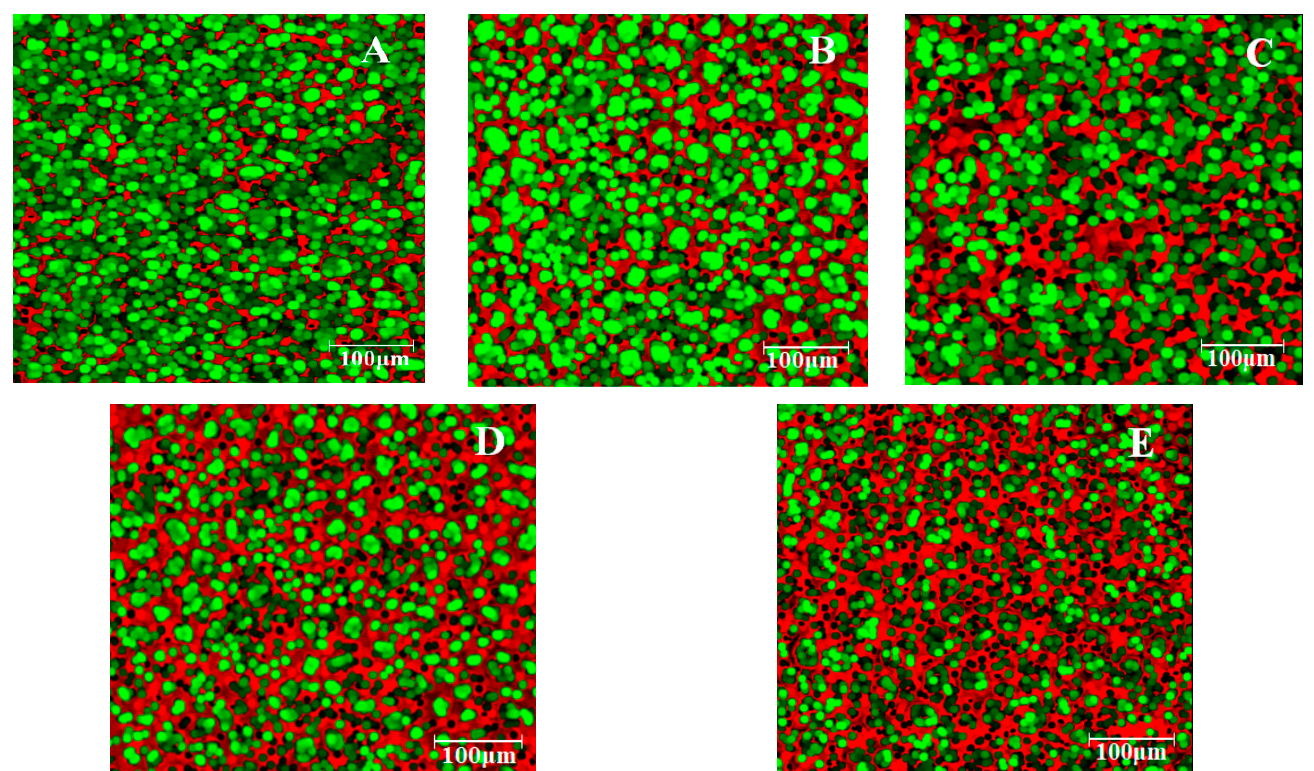
Figure 3. Microstructure taken by EFLM of wheat dough with germinated lupin flour (GLF) at different levels: 0% ( A ), 5% ( B ), 10% ( C ), 15% ( D ) and 20% ( E ). Red, protein; Green, starch granules.